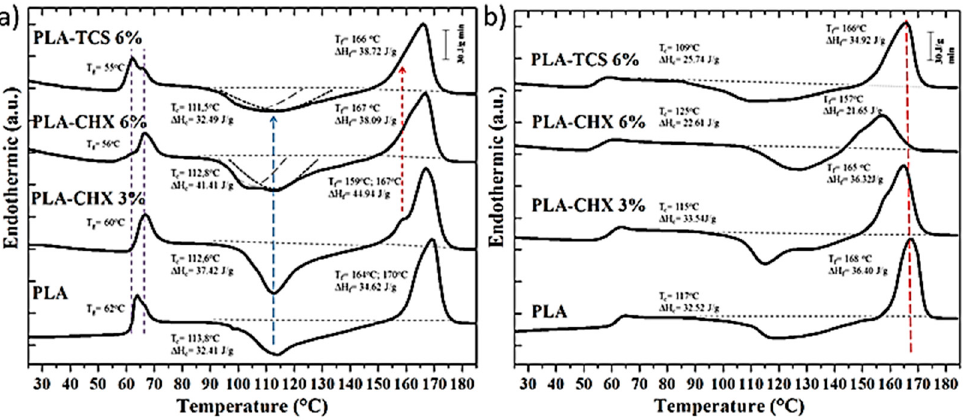
Figure 9. Differential scanning calorimetric curves corresponding to the first heating ( a ) and second heating ( b ) runs of neat PLA, PLA loaded with 3% and 6% of CHX and PLA loaded with 6% of TCS. Both heating runs were performed at 10 °C/min.